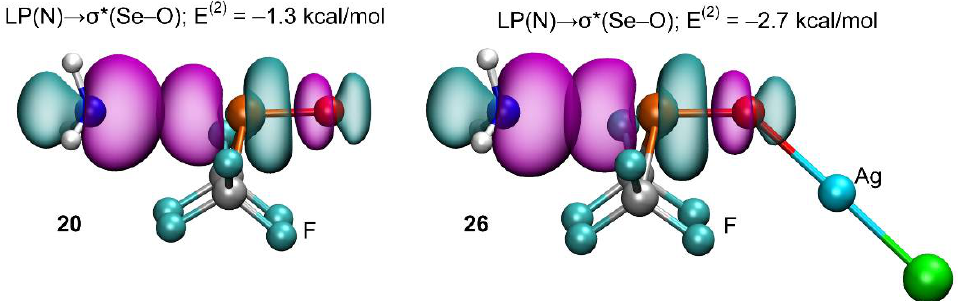
Figure 8. Plot of the filled lone pair (NH 3 ) and empty σ *(Se–O) NBOs (isosurface 0.008 a.u.) that participate in the LP(N) → σ *(Se–O) donor-acceptor interaction in complexes 20 ( left ) and 26 ( right ). The second order perturbation energies E (2) are also